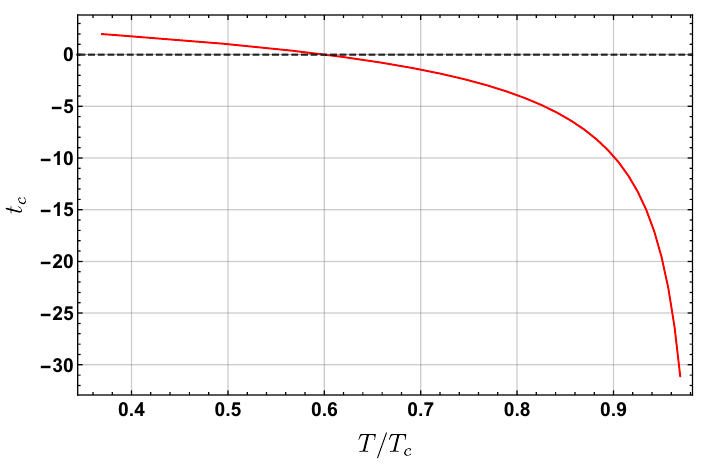
Figure 13 . Relation between the critical time t c and the temperature of the superconducting black hole of (2.8). t changes sign at T ≈ 0 . 6 T . We have fixed the chemical potential µ = 1 c c